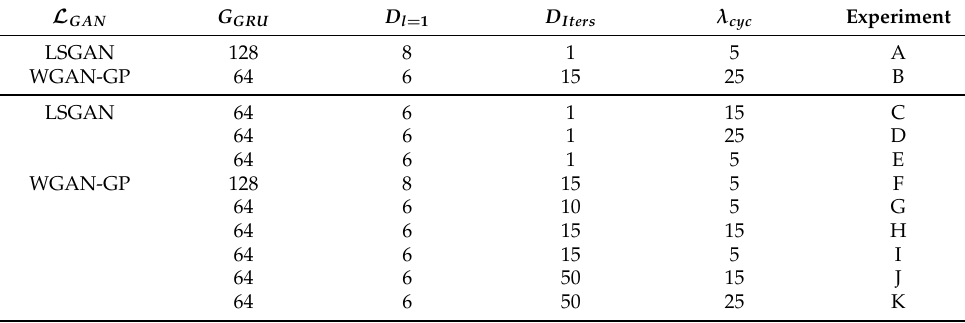
Table A1. Experiments and their hyperparameters.